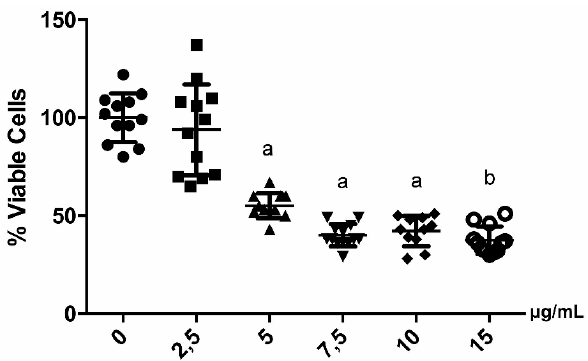
Figure 2. Cell viability analysis of Chondrocytes after EEP treatment. Quantification of cell viability with trypan blue, after application in the supernatant of different doses of propolis for 24 h in culture